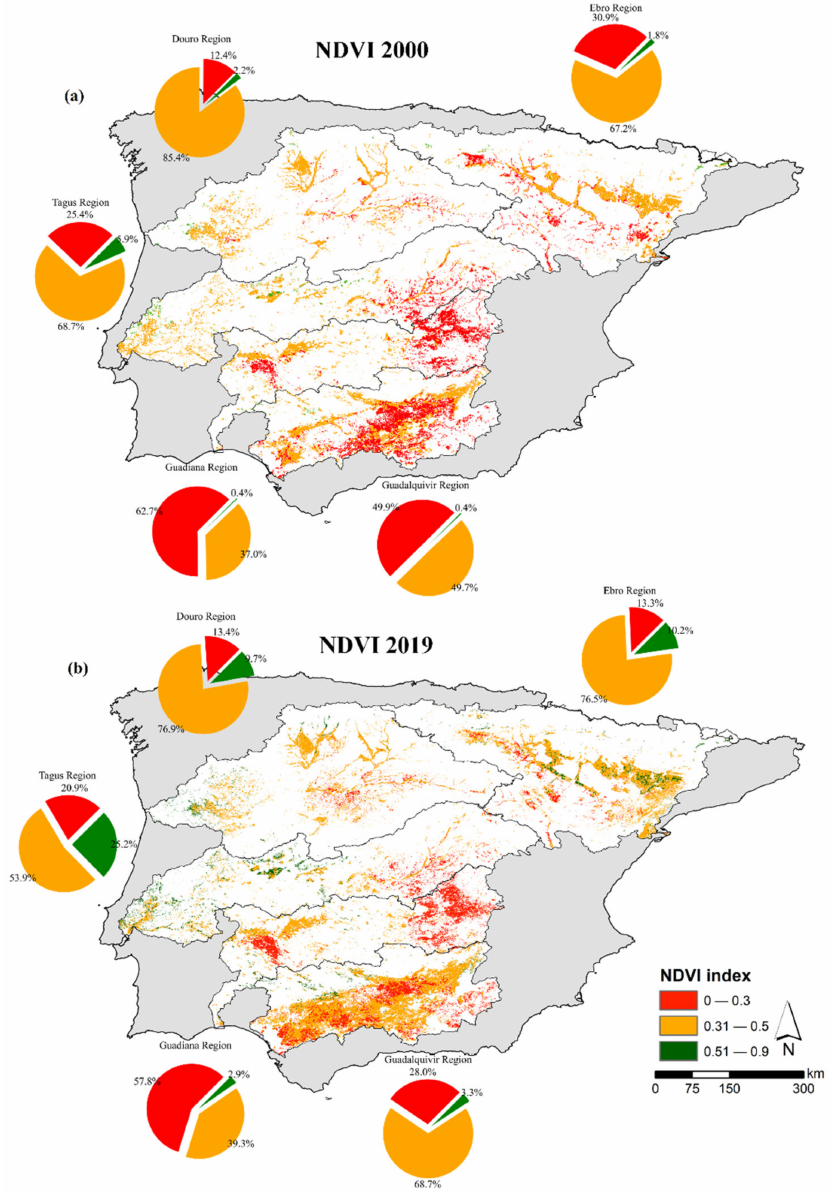
Figure 3. Normalized difference vegetation index (NDVI) in water-dependent areas in the Iberian Peninsula, for the years ( a ) 1990 and ( b ) 2020. Pie charts show the percentage of area evolution from one period to